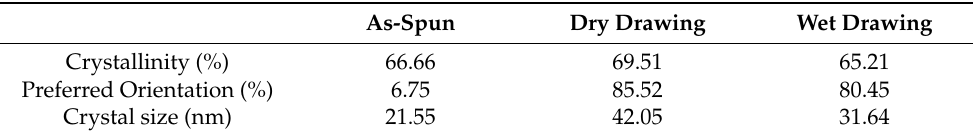
Figure 5. Two-dimensional wide-angle X-ray diffraction (WAXD) images of general wet-spun PAN fibers. ( a ) as-spun, ( b ) dry drawing, ( c ) wet drawing fiber, ( d ) 1D equatorially extracted XRD plot, and ( e ) Azimuthal scans at 2 θ = 17 ◦ . Table 2. Microstructural characterization results of PAN